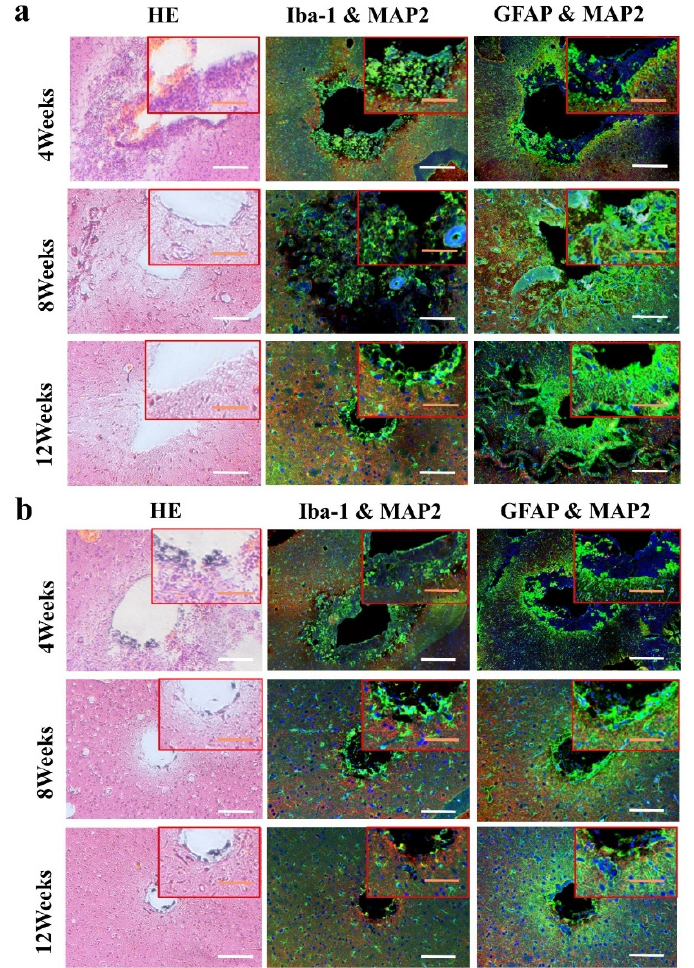
Figure 10. Immunohistochemical detection of electrode in vivo. ( a ) Metal electrode group; ( b ) bioelectrode group (Green: GFAP and Iba-1, astrocytes and microglial; red: MAP2, neuron; blue: DAPI, nucleus. The white bar represent 100 µ m; the orange bar represent 50 µ m).